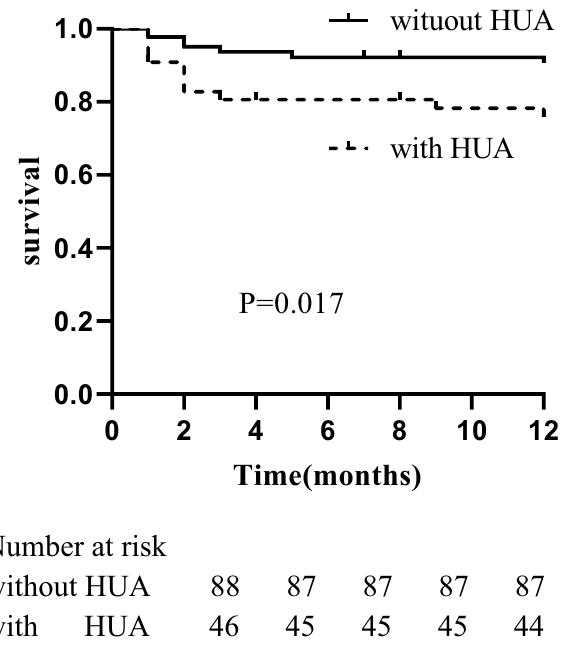
Figure 2. Kaplan–Meier survival curve for ANCA-related renal vasculitis patients.